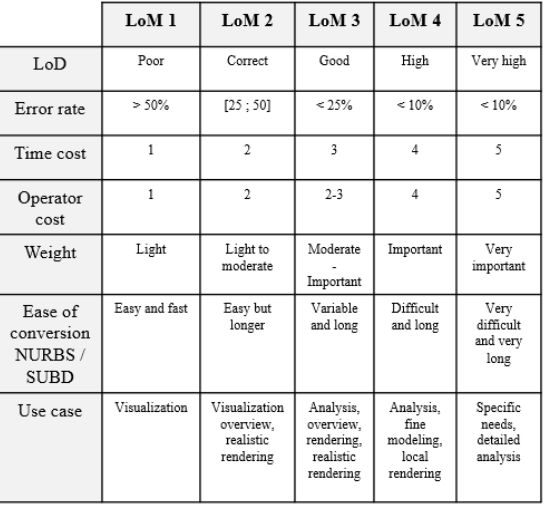
Table 3 : Level of Modelling